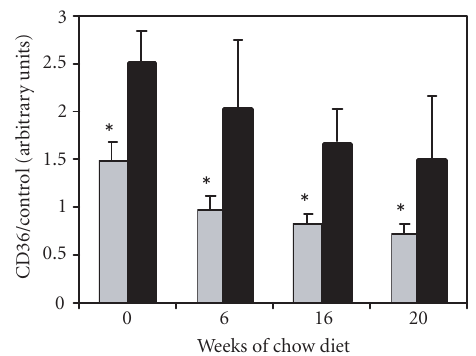
(b) Quantification of heart CD36 signals reported to a control protein. C57BL/6 is shown in light gray while apoE is shown in black. ∗ P < . 05 compared to deficient apoE mice. Figure 3. Western blot analysis of CD36 protein levels in the heart. blots of heart and testis showed CD36 mRNA levels to be sig- nificantly increased, at 6, 16, and 20 weeks in apoE − / − , com- pared to wild type. (2) Likewise, CD36 protein expression levels in hearts and testis was increased at 6, 16, and 20 weeks in apoE − / − , compared to wild type. (3) Wild-type mice did not show, between 0 and 20 weeks of diet, changes in